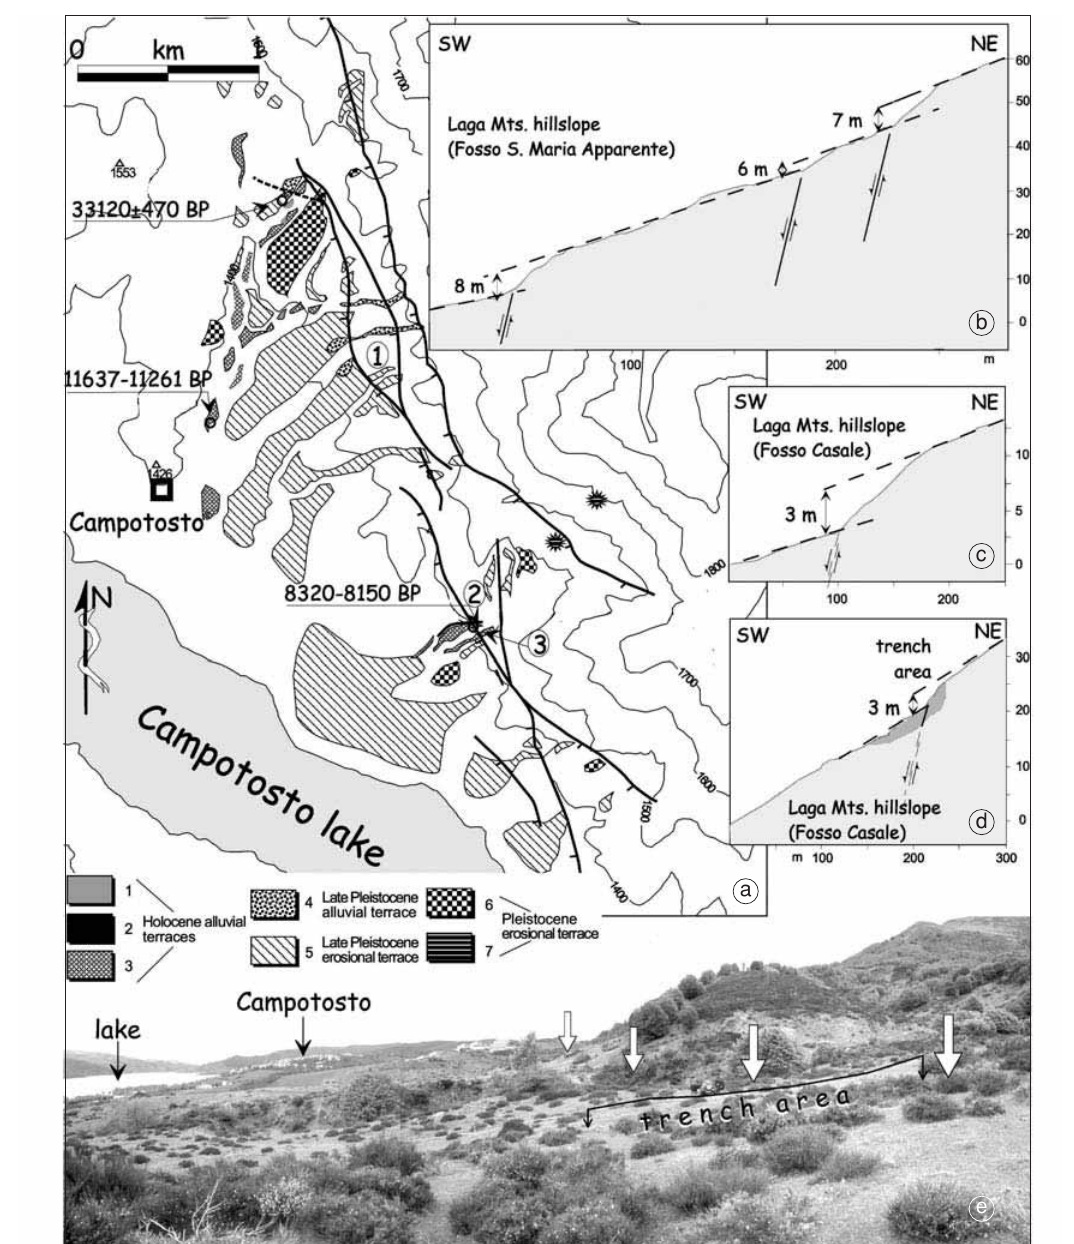
Fig. 9a-e. a) Geomorphological map of the Campotosto area; the trench was excavated at site 3; b,c,d) topo- graphic profiles across the Laga Mts. Fault made at sites 1, 2 and 3, respectively; e) panoramic view of the trench